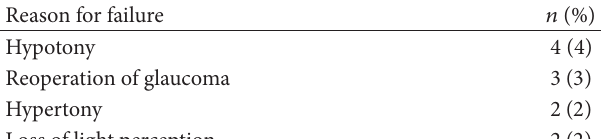
Table 2: Primary reason for surgical failure.